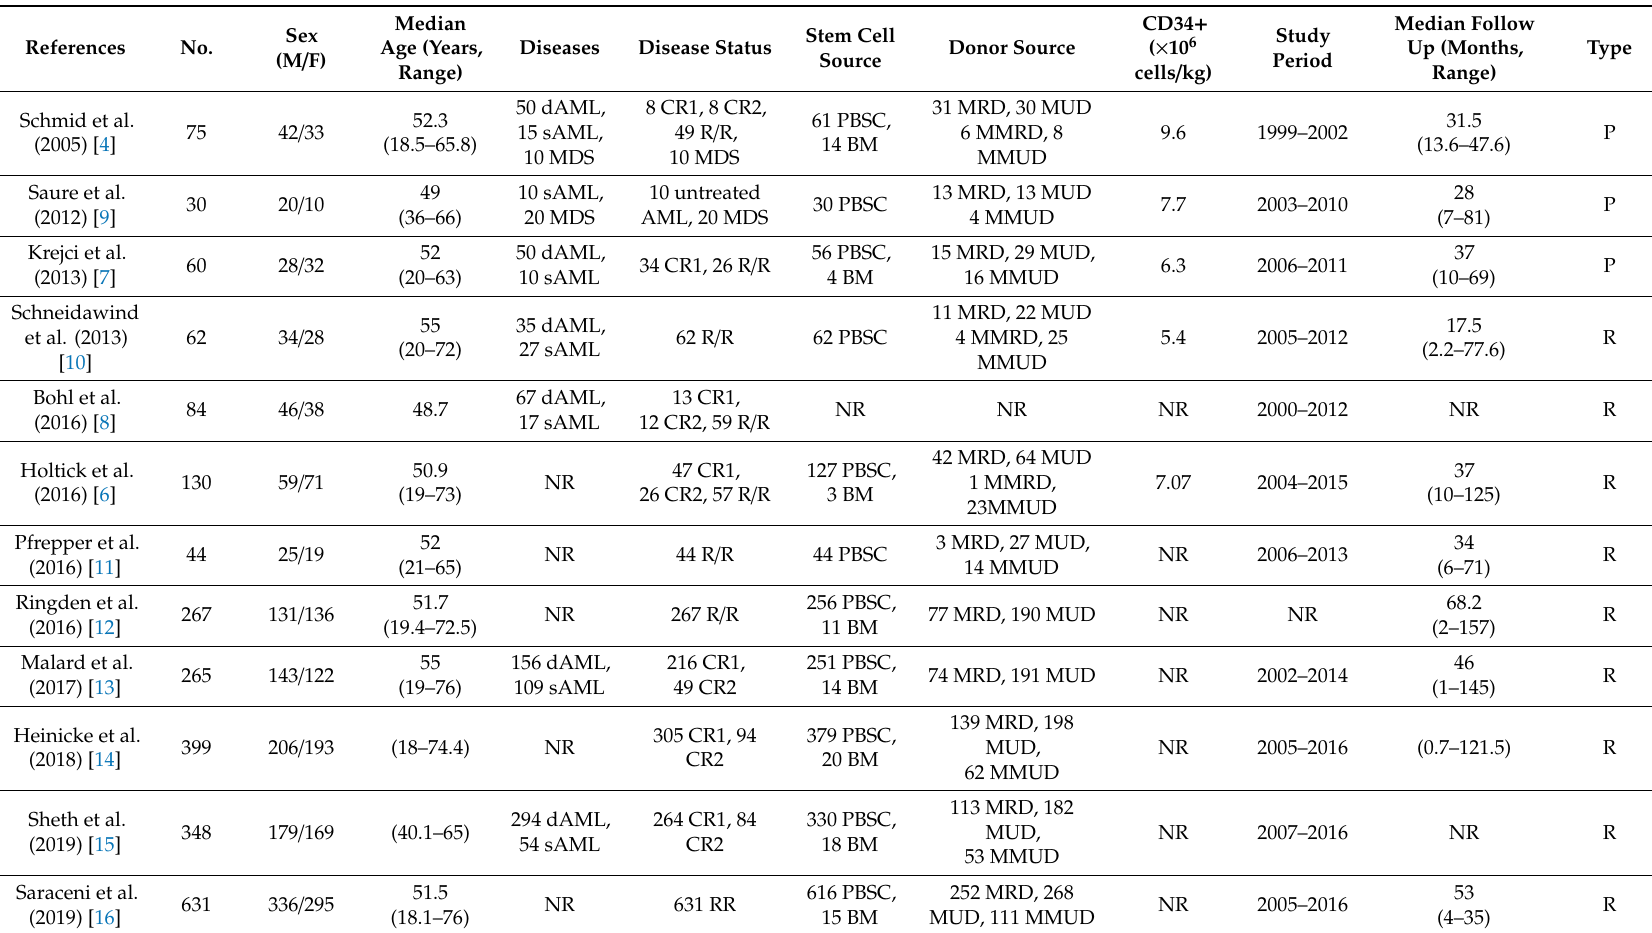
Table 1. Baseline patient characteristics of each included